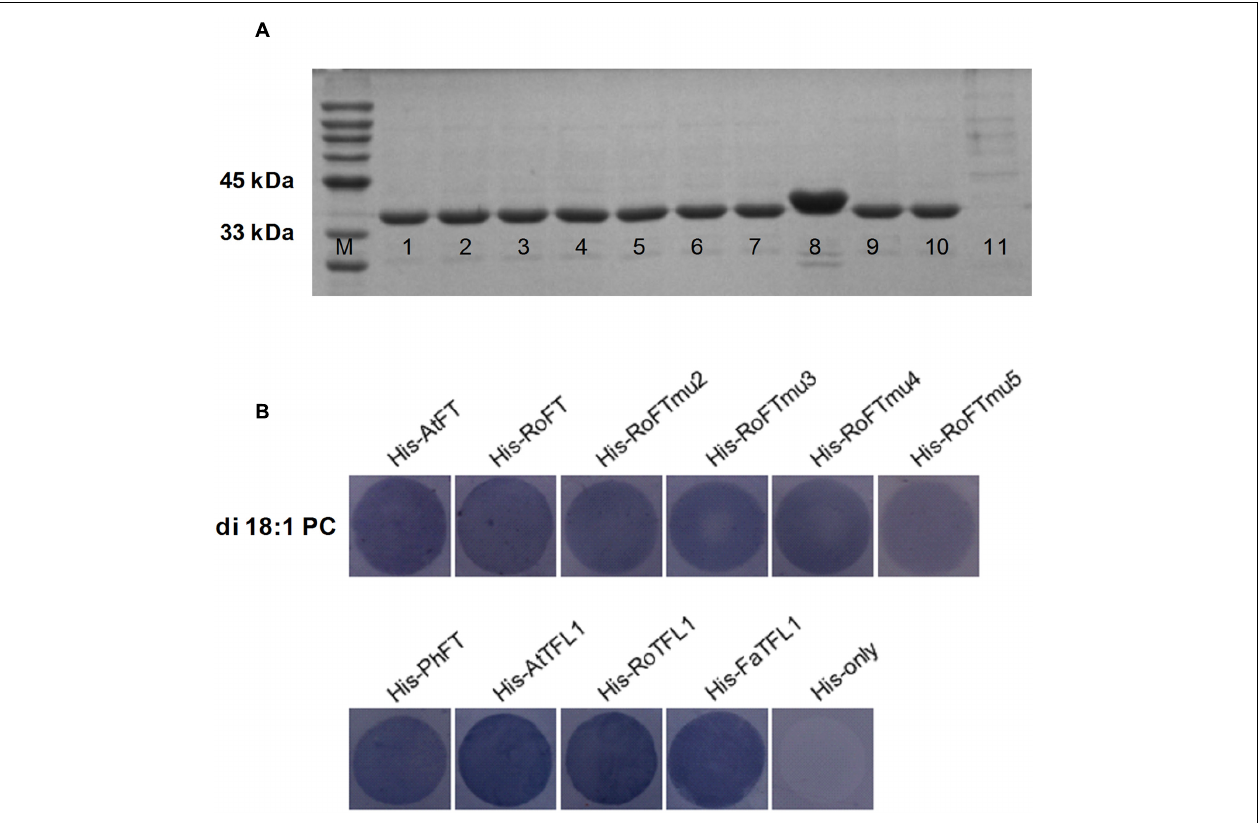
FIGURE 7 | FT proteins binding to phosphatidylcholine (PC). (A) His-FT/TFL1 purified proteins on SDS-PAGE Gel. M, Protein Marker; 1-11, His-AtFT, His-RoFT, His-RoFTmu2, His-RoFTmu3, His-RoFTmu4, His-RoFTmu5, His-PhFT, His-AtTFL1, His-RoTFL1, His-FaTFL1, His-only. (B) Various His-FT/TFL1 proteins binding to di 18:1 PC on the membrane. The His-AtFT and His-only with PC binding was used as a positive and negative control,